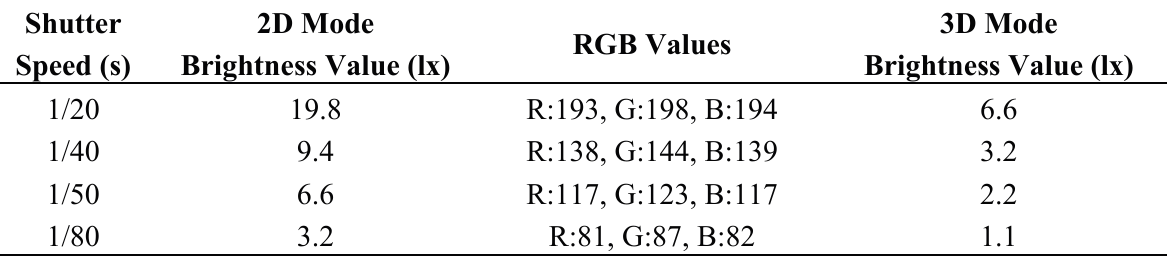
Table 8. F10 aperture experimental results.